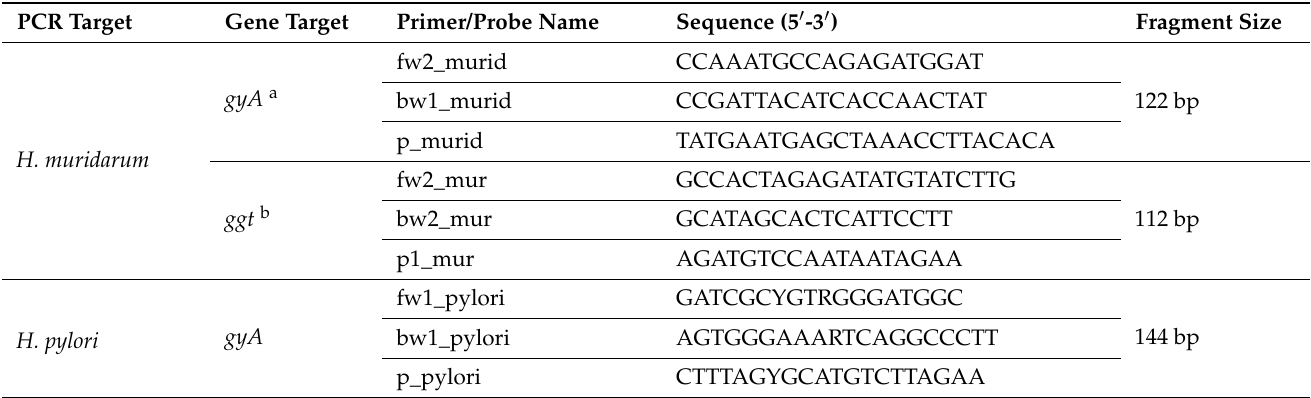
Table 2. Helicobacter genus- and species-specific primers in the Helicobacter multiplex DNA